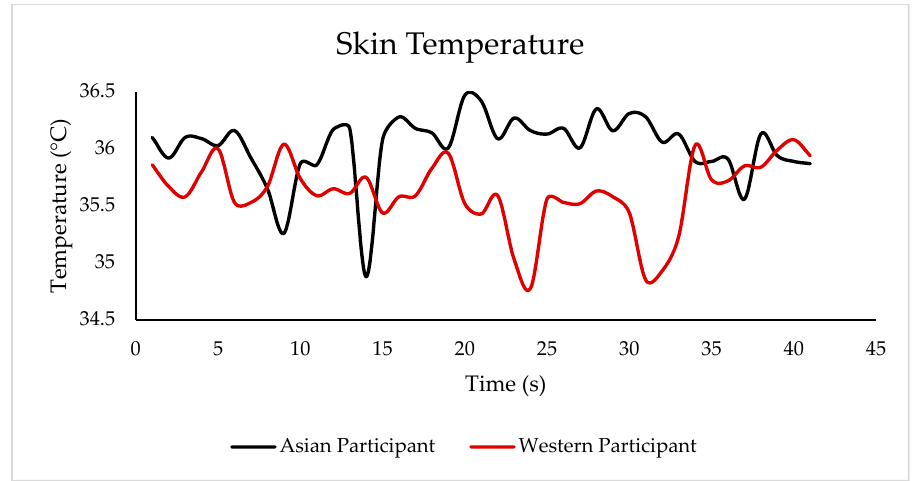
Figure 7. Example of the skin-temperature changes overtime when tasting a porter beer using the responses of an Asian and a Western participant.